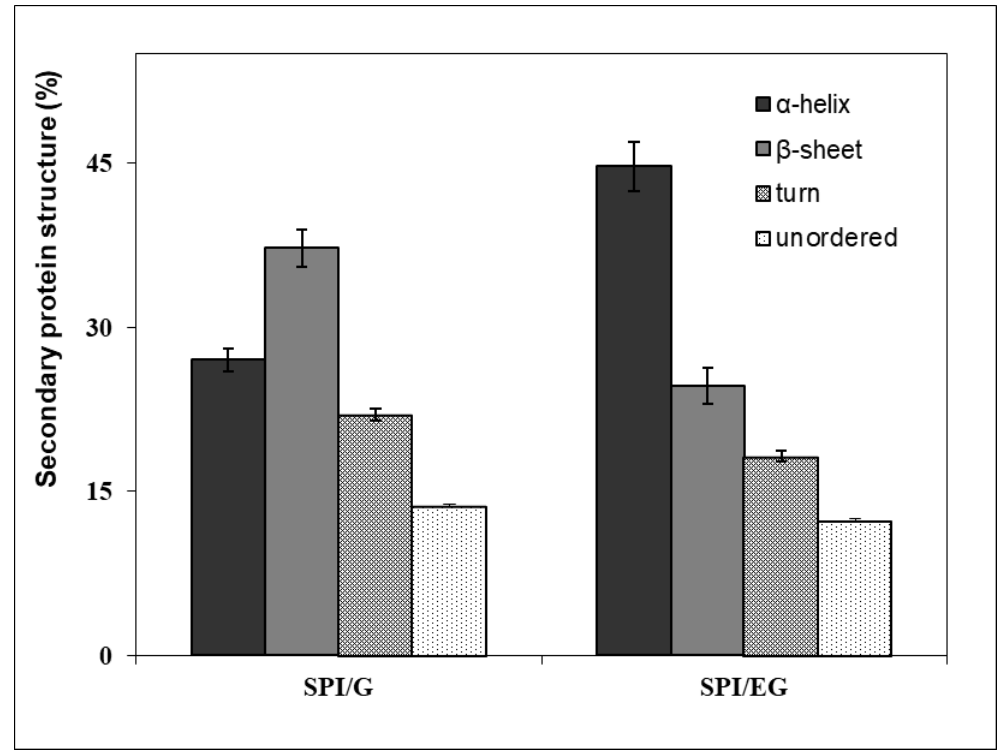
Figure 2. Percentages of α-helix, β-sheet, turn and unordered protein structures of oil-free SPI gels (SPI/G) and SPI emulsion gels with chia oil (SPI/EG). See Table 1 for sample formulation.